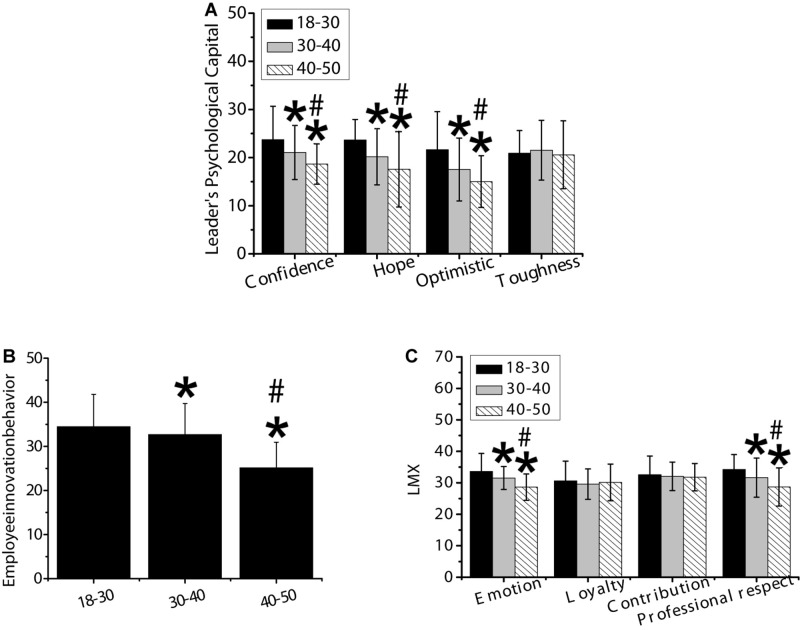
Differences in psychological capital, employee innovation behavior, and LMX of leaders with different ages. Panel (A) was confidence, hope, optimism, and resilience; panel (B) was innovative behavior of employees; panel (C) was affection, loyalty, contribution, and professional respect. * meant that the difference was statistically significant compared with those aged 18–30 (p < 0.05); # indicated that there was a statistically significant difference compared with those aged 30–40 (p < 0.05).